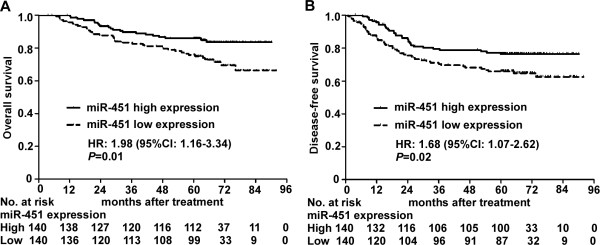
Downregulation of miR-451 is associated with worse survival in NPC patients. (A) Overall survival. (B) Disease-free survival. HR, hazard ratio, and CI, confidence interval; HR values were calculated with the unadjusted Cox regression analysis, and P values were calculated with the log-rank test.